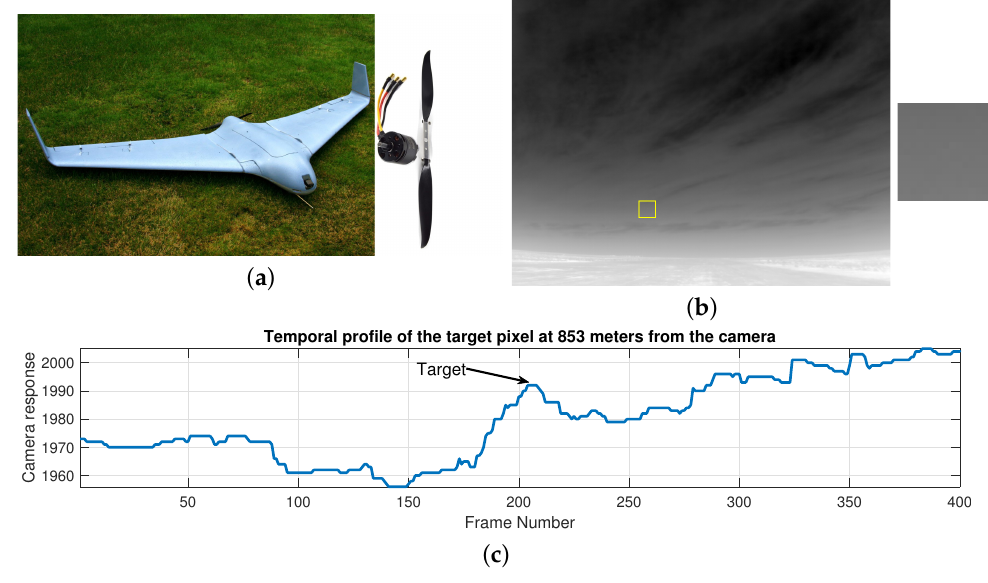
Figure 1. ( a ) A small size Skywalker X8 UAV (79 cm physical length, 212 cm wing span). The main structure is composed of foam and plastic components. The propeller is a 900 Watts small (42 mm CAN diameter) electric brush-less motor. The X8 is a typical example of a small size and minimal thermal signature target. ( b ) Infrared image (minmax scaled) of the target captured using a thermal IR camera (ICI-8640) having a spatial resolution of 640 × 512. The target is at 853 m distance from the camera. Zoomed target region is shown on the right. Due to the small thermal signature of the X8, its brightness and raw spatial contrast are very low compared to the background clutter. ( c ) Raw camera response of the target pixel over time (400 frames). The temporal contrast of the target is also low due to its large distance from the